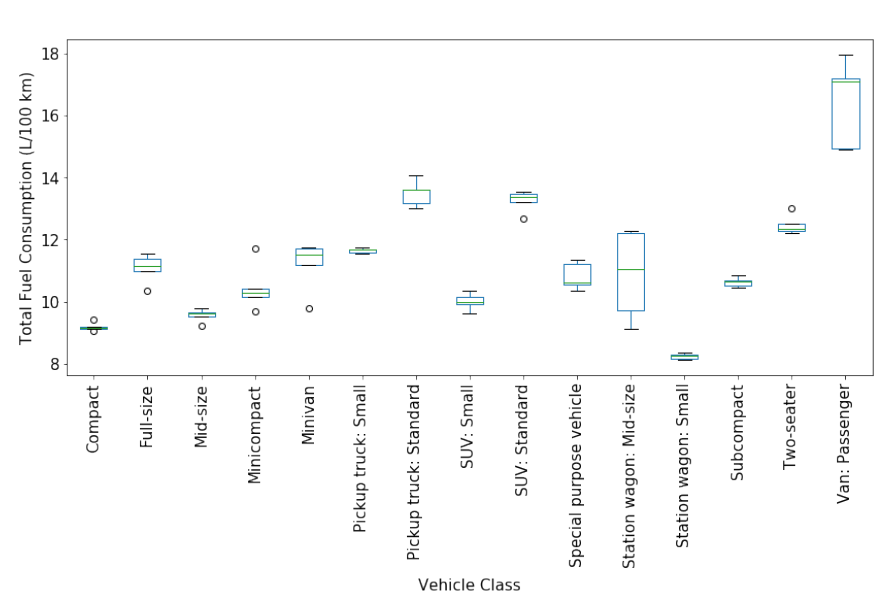
Figure 9. Total fuel consumption distribution of vehicle classes over time.